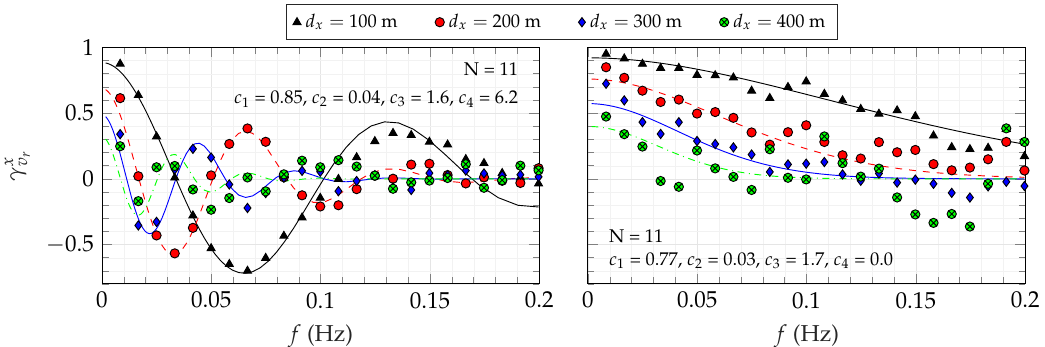
Figure 11. Measured (markers) and fitted (lines) along-beam coherence, obtained using the staring Line-Of-Sight scan of the Lidar East (North-South configuration), with 10 m β yaw angle 2 ◦ , without ( left ) and with ( right ) synchronization of the time series considering a | | ≤ time lag equal to d x / u